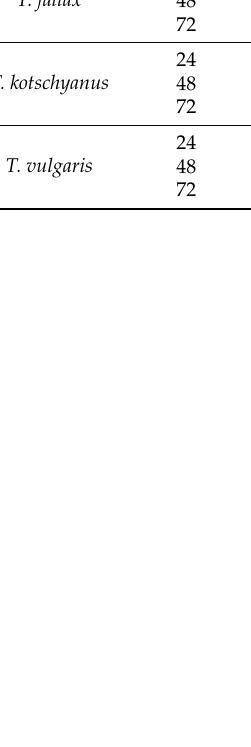
Table 3. The effects of LC 30 and LC 50 values of Thymus eriocalyx , T. fallax , T. kotschyanus , and T.